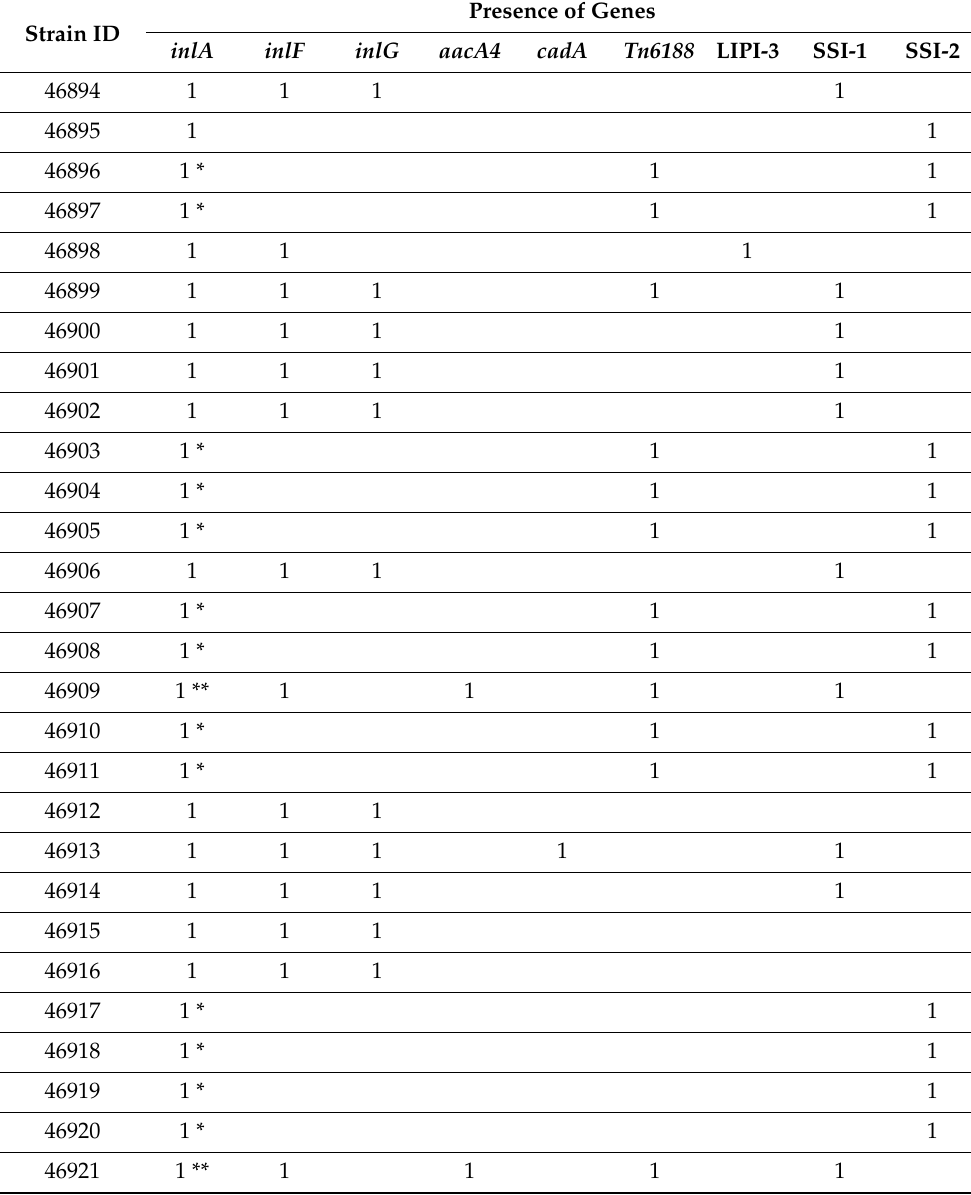
Table 2. Presence of selected genes among L. monocytogenes strains tested. Strain ID